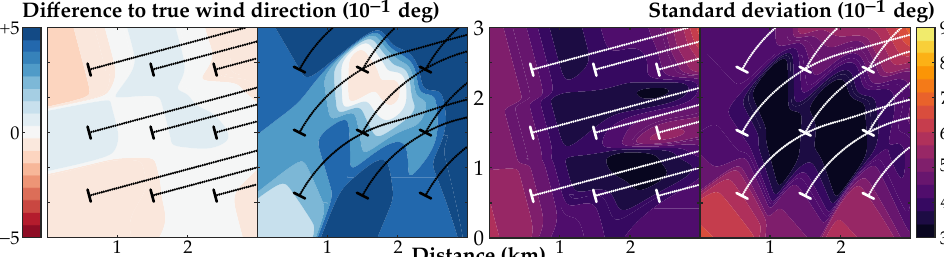
Figure 10. The left figure pair shows the difference to the true value and the value extrapolated from the OPs’ wind direction states. A blue color indicates that the extrapolated wind direction is trailing the true value during the direction change. The true values are 255 deg at t 1 = 600 s and 207 deg at t 2 = 840 s, left and right, respectively. The right figure pair shows the standard deviation of the state values based on the variance across the